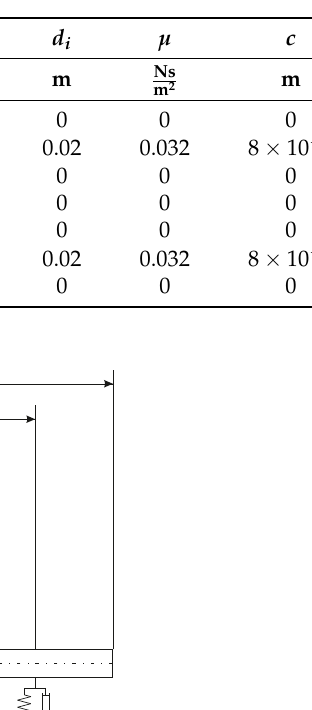
Table 1. Stations of the numerical example.